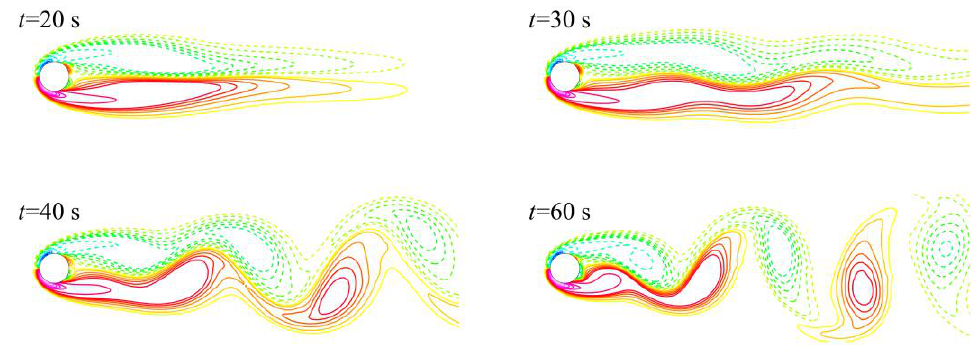
Figure 4. Time history of drag and lift coefficient for Re = 100.